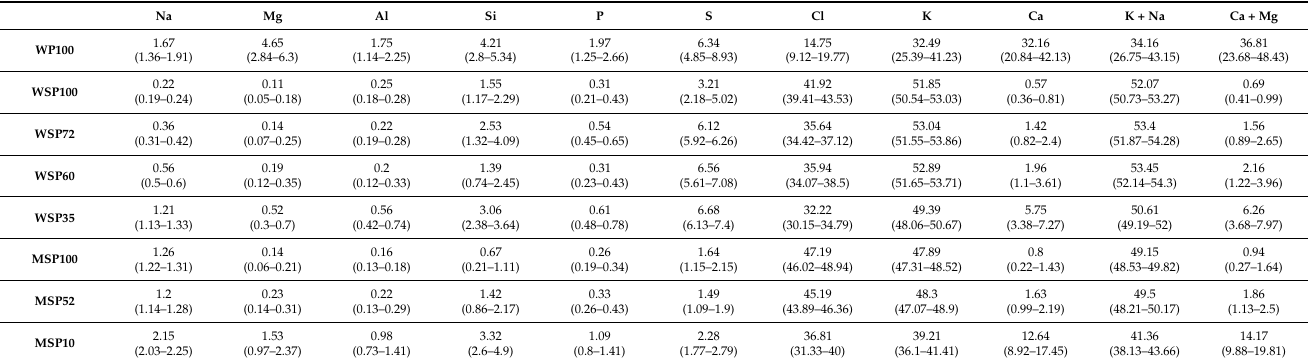
Figure 4. P concentration in bottom ash versus P concentration in fuel preliminary analysis. Table 6. Mean values (range) of the elemental composition (SEM-EDS) of deposits expressed as a percentage of the total mass of measured elements (Na, Mg, Al, Si, P, S, Cl, K and Ca) (%m/m: mass